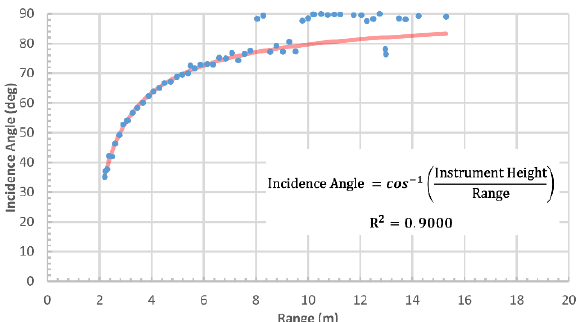
Figure 8. Example of correlation between range and incidence angle for the points on the stripe where the instrument height was 1.79